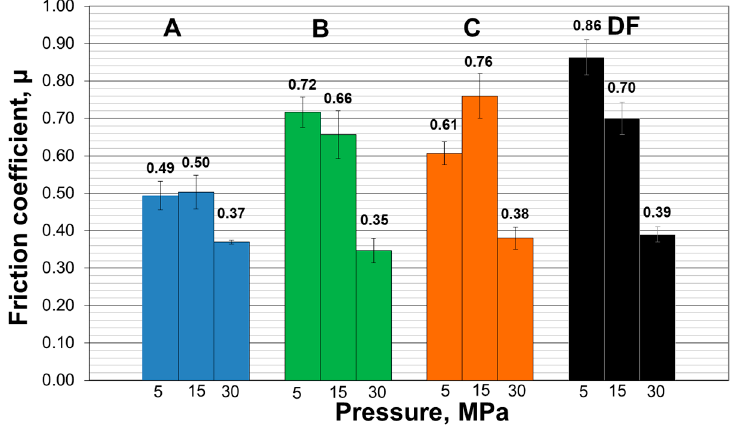
Figure 4. Impact of human saliva and its substitutes on friction coefficient values under stable conditions: A—human saliva, B—mucin III in PBS, C—mucin III + xanthan gum in PBS, DF—dry friction.